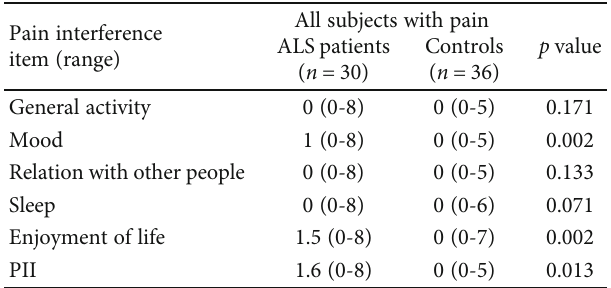
PII: Pain Interference